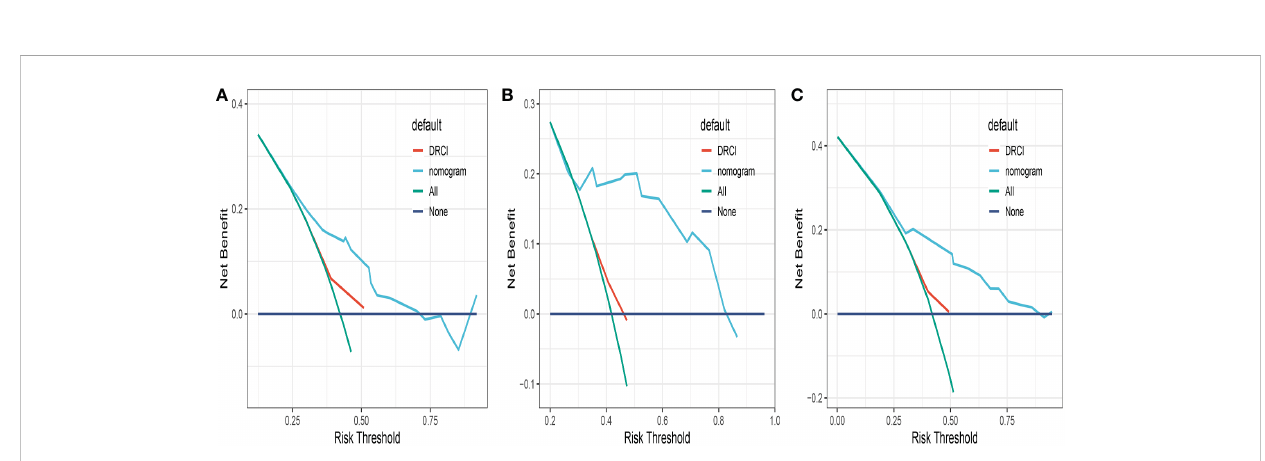
FIGURE 6 Comparison of the decision curves between the nomogram and the DRCI in the training (A) , validation (B) and entire cohort (C)